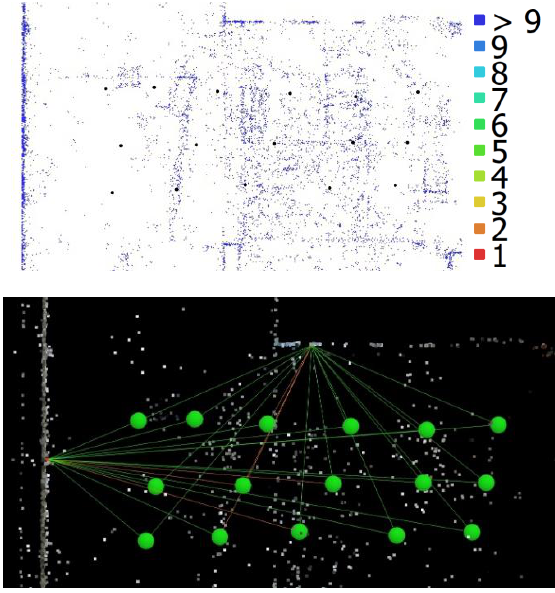
Figure 3. Spherical images provide a significant overlap. In this example, the same point is theoretically visible in all the images. However, this does not mean that the automatic extraction of tie points will provide matches visible in the whole dataset.